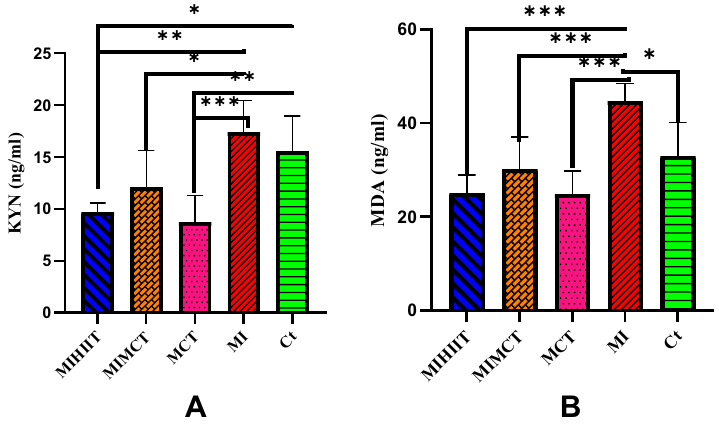
Figure 1. KYN ( A ), and MDA ( B ) levels in heart tissue of rats. MDA and KYN levels of the heart tissue were affected by the MI condition. Training had different effects on the treated groups. Abbreviations: Ct control group, MI the group with occlusion of the left coronary artery, MICT the group treated with moderate intensity of continuous training, MIMCT rats with left coronary artery occlusion treated with moderate intensity of continuous training, MIHIIT rats with left coronary artery occlusion treated with high-intensity interval training.